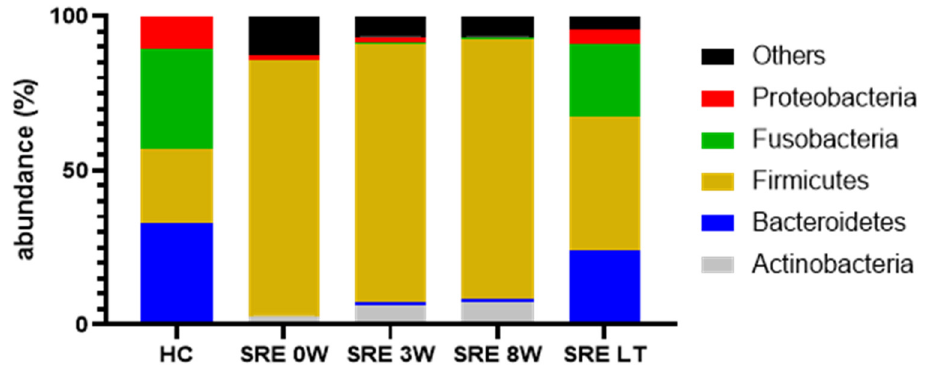
Figure 2. Median abundance of the 5 major bacterial phyla in fecal samples from healthy controls (HC) and dogs with steroid-responsive enteropathy (SRE). While there was no visible change in the microbiome composition of dogs with SRE after up to 8 weeks of treatment, a significant recovery can be seen for the long-term (LT) follow up, and the abundance of all 5 phyla was no longer significantly different from healthy